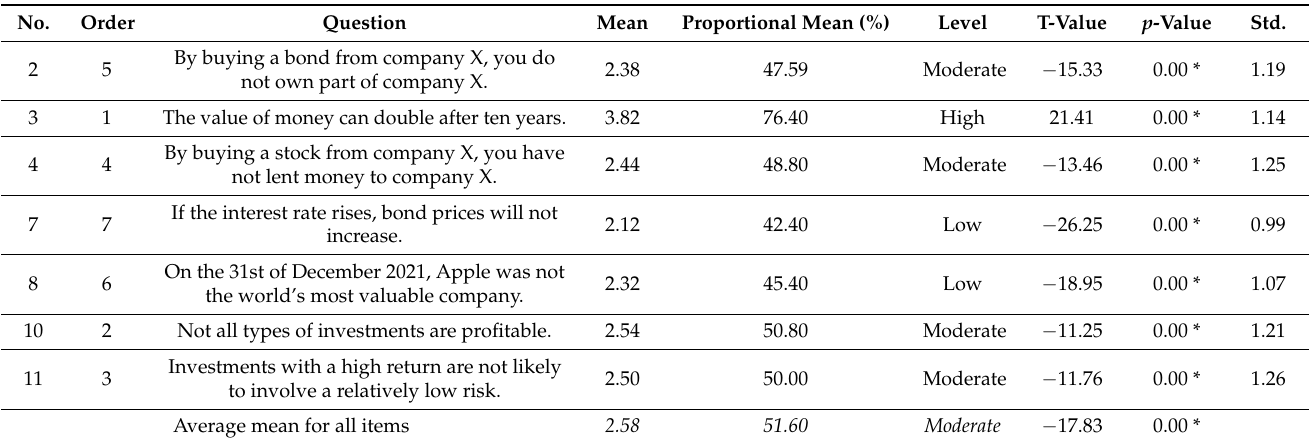
Table 5. Investment: Mean and std. values for financial literacy levels ( n =